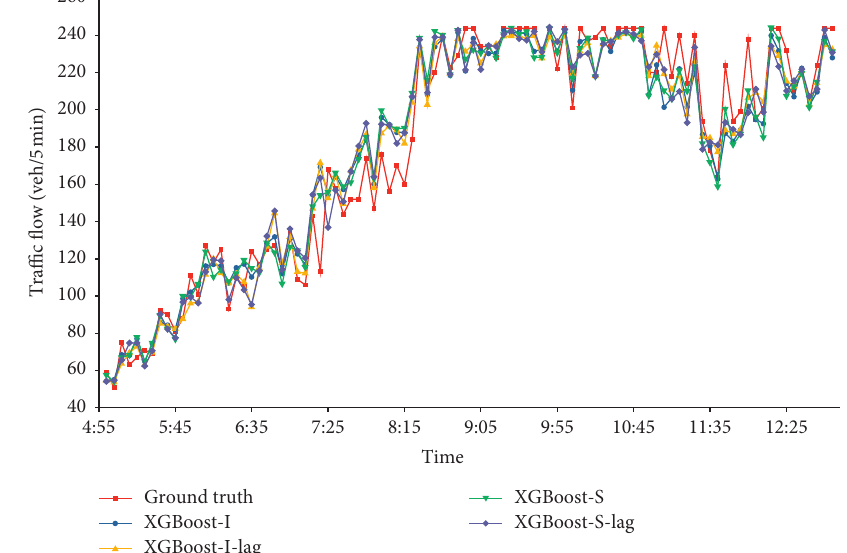
Figure 9: The four XGBoost models on the first-day predicted results and ground